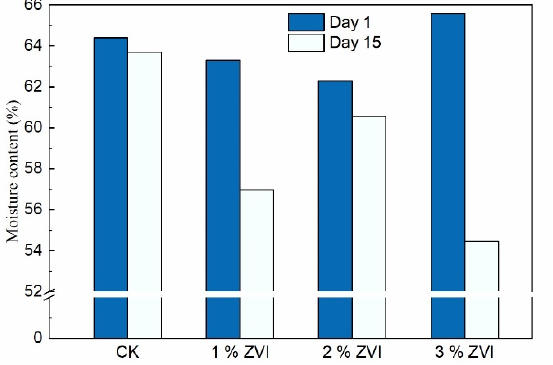
Figure 5. Changes in moisture content of the compost material under different ZVI additions. ZVI: zero-valent iron.